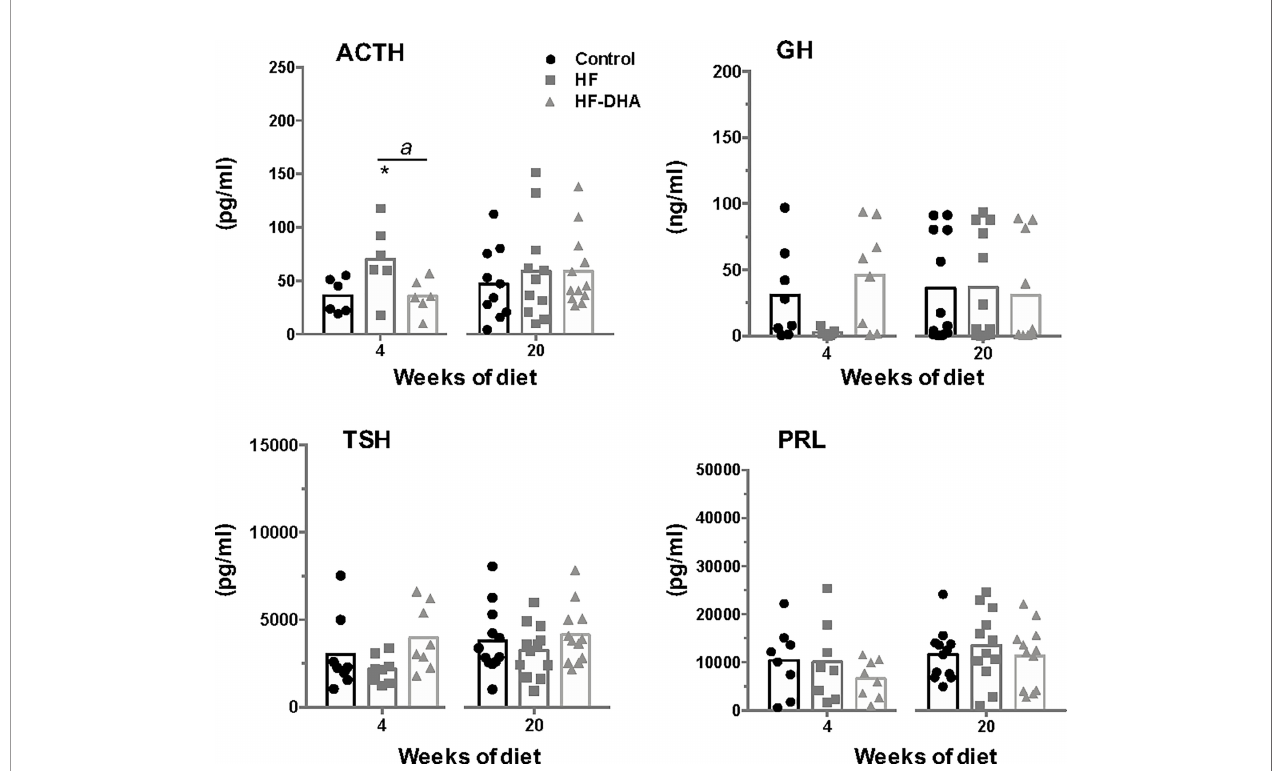
FIGURE 7 | Circulating levels of non-gonadotrope pituitary hormones rats after short-term or long-term high-fat diets. Serum levels of the pituitary hormones, ACTH, GH, PRL and TSH, were measured after 4 and 20 weeks of diet as described in Materials and Methods . The bar height re fl ects the mean. Data are expressed as means ± SEM (n= 6-8 and n=10-12 rats for short- and long-term diets, respectively) and were analyzed with Kruskal-Wallis test followed by Dunnett ’ s multiple comparison test. * P ≤ 0.05 vs control. a P ≤ 0.05 between HF and